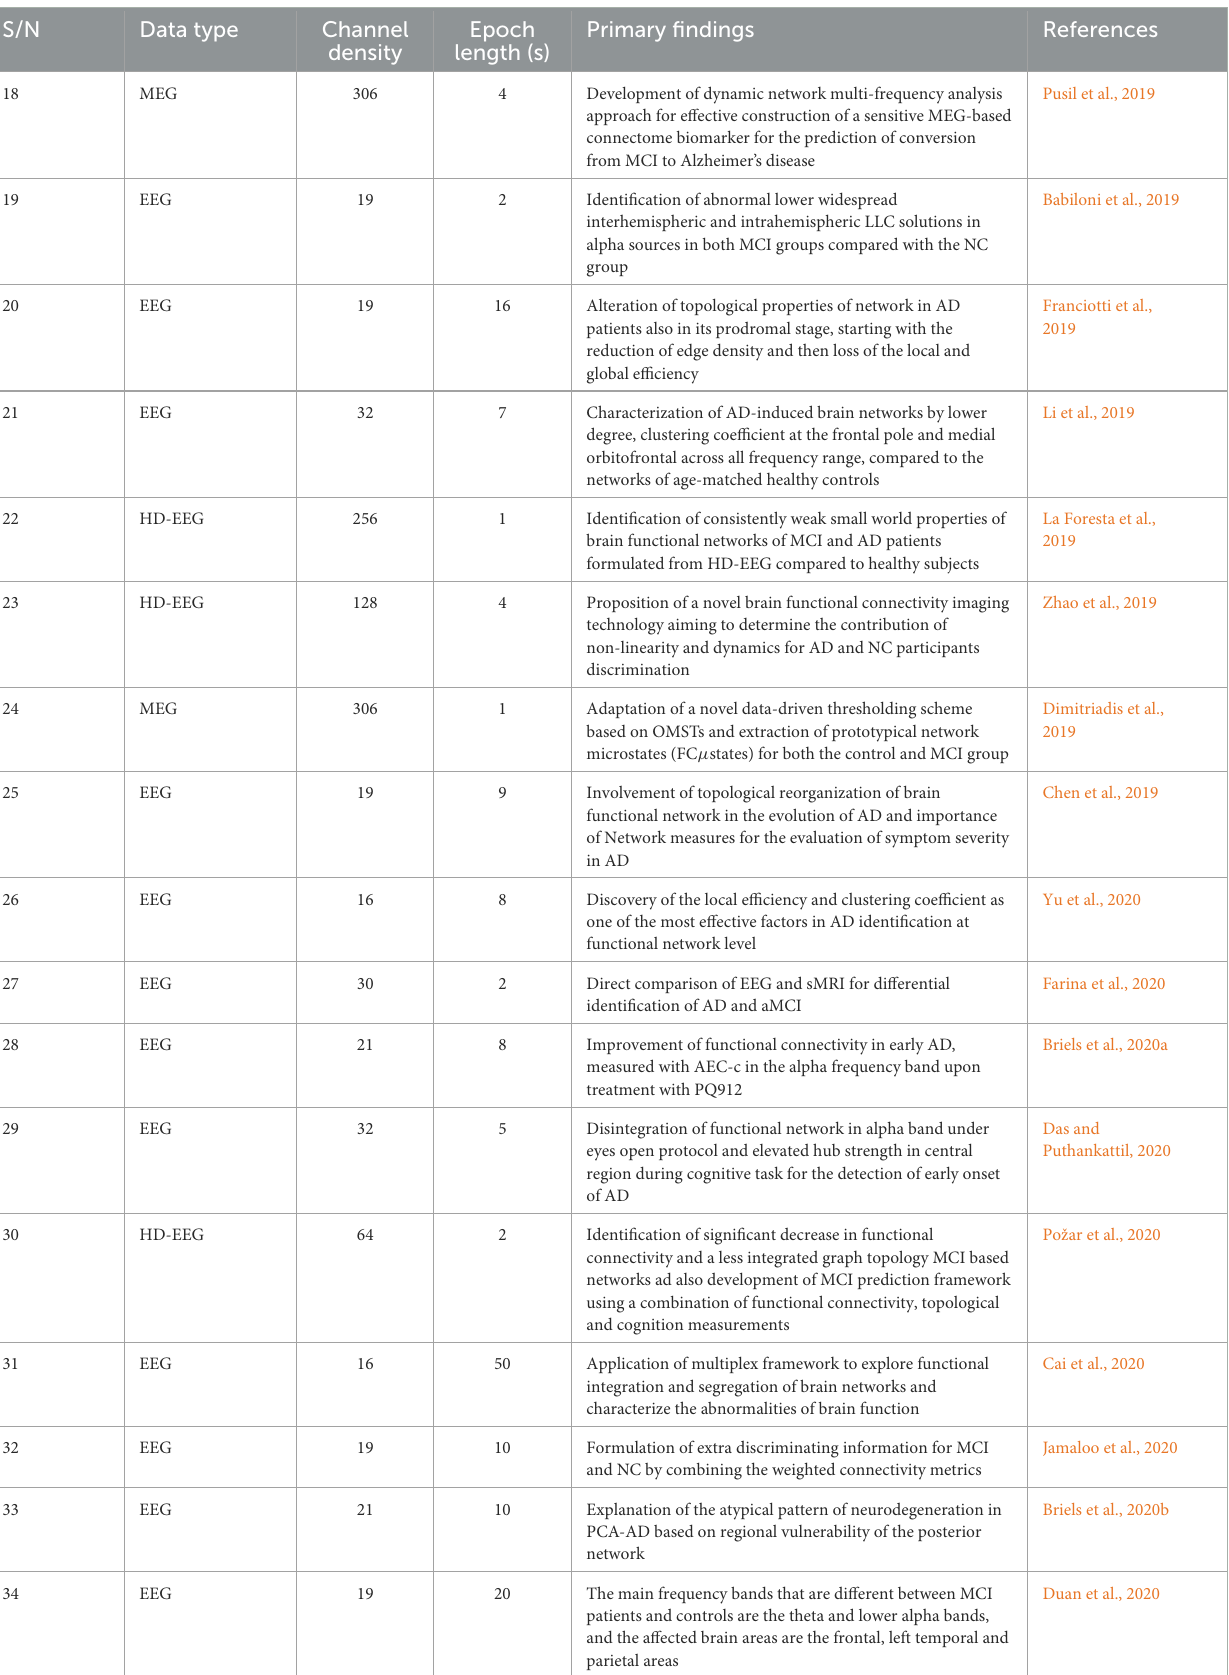
The main frequency bands that are different between MCI patients and controls are the theta and lower alpha